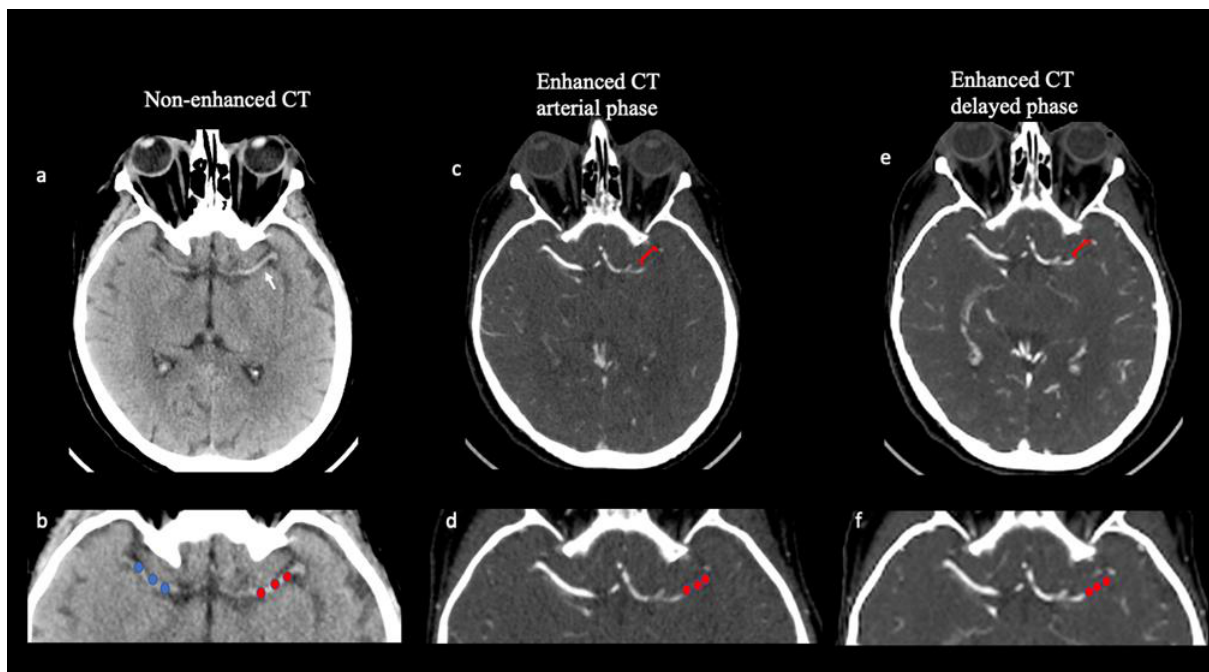
Figure 1. Thrombus attenuation measurements and thrombus perviousness quantification. Axial non-contrast CT (NCCT; a , b ) demonstrates a hyperattenuating ("dense") middle cerebral artery (MCA) (white arrow in a) in a 67-year-old patient with acute stroke. Thrombus attenuation measurement was calculated on NCCT as the difference between thrombus average density and contralateral artery by placing 3 spherical ROIs in the proximal, middle, and distal parts of the thrombus in the M1 segment of the left middle cerebral artery (red ROIs in b) and along the same vessel on the contralateral side (blue ROIs in b). Multiphase CTA (mCTA; c – f ) identifies occlusion length of the M1 segment of the left middle cerebral artery, demonstrated as contrast-filling defects (square bracket in c , e ). Three regions of interest (red ROIs) were placed in a left middle cerebral artery thrombus both in the arterial ( c , d ) and in the delayed phases ( e , f ) of the mCTA. Clot perviousness measurement was calculated as the difference in average thrombus attenuation measured on the arterial or delayed phase of mCTA and on NCCT.